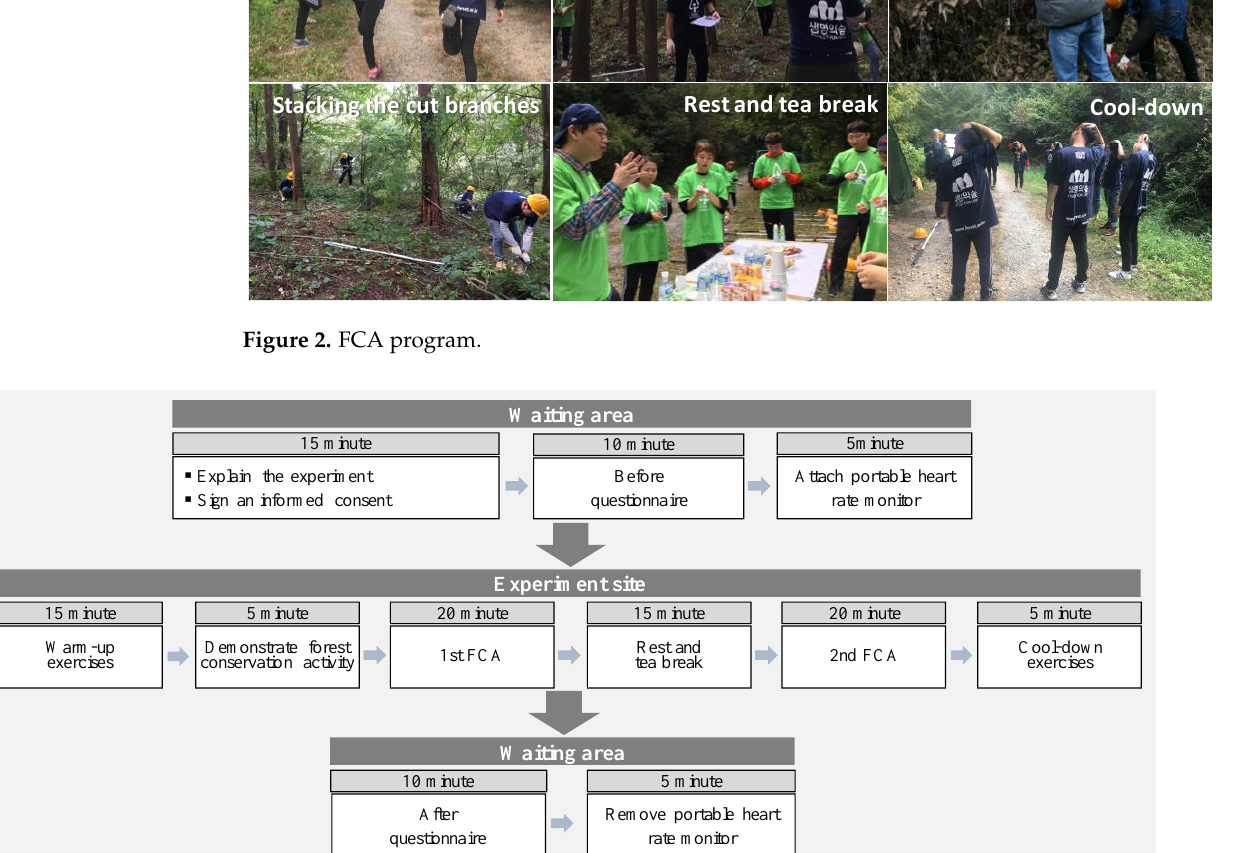
Figure 3. Experimental procedure flow chart.